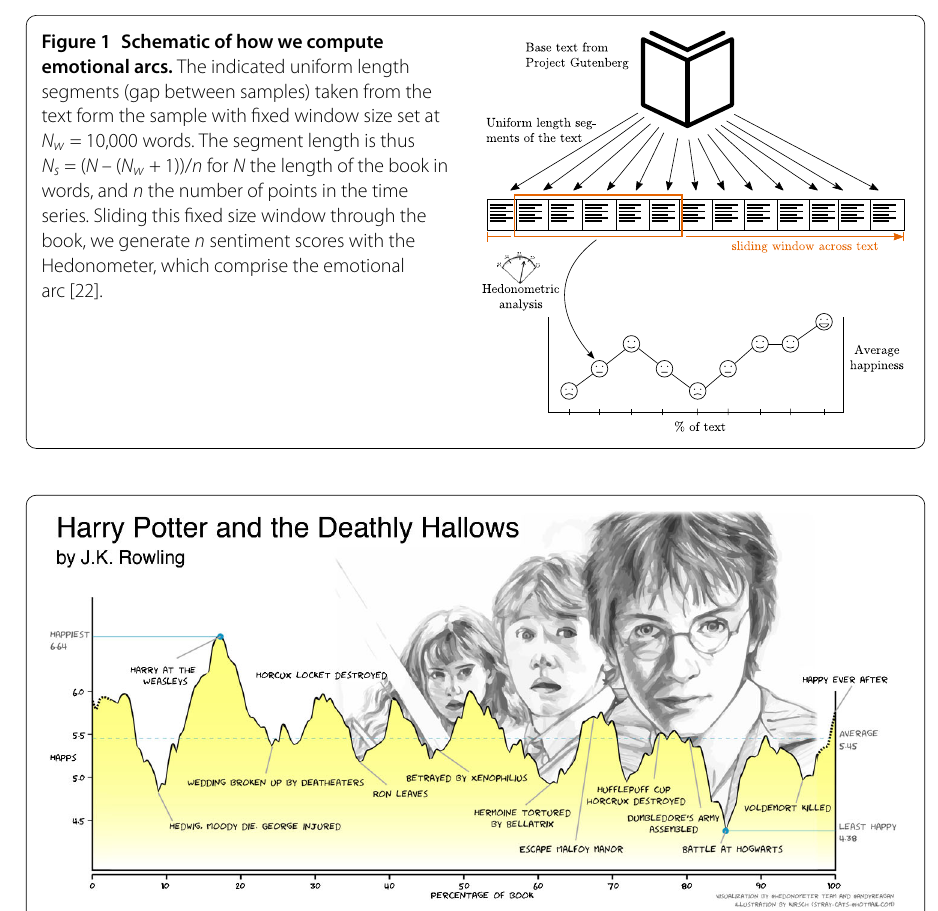
Figure 2 Annotated emotional arc of HarryPotterandtheDeathlyHallows , by JK Rowling, inspired by the illustration made by Medaris for The Why Files [23]. The entire seven book series can be classified as a ‘Kill the monster’ plot [24], while the many sub plots and connections between them complicate the emotional arc of each individual book: this plot could not be readily inferred from the emotional arc alone. The emotional arc shown here, captures the major highs and lows of the story, and should be familiar to any reader well acquainted with Harry Potter. Our method does not pick up emotional moments discussed briefly, perhaps in one paragraph or sentence ( e.g. , the first kiss of Harry and Ginny). We provide interactive visualizations of all Project Gutenberg books at http://hedonometer.org/books/v3/1/ and a selection of classic and popular books at